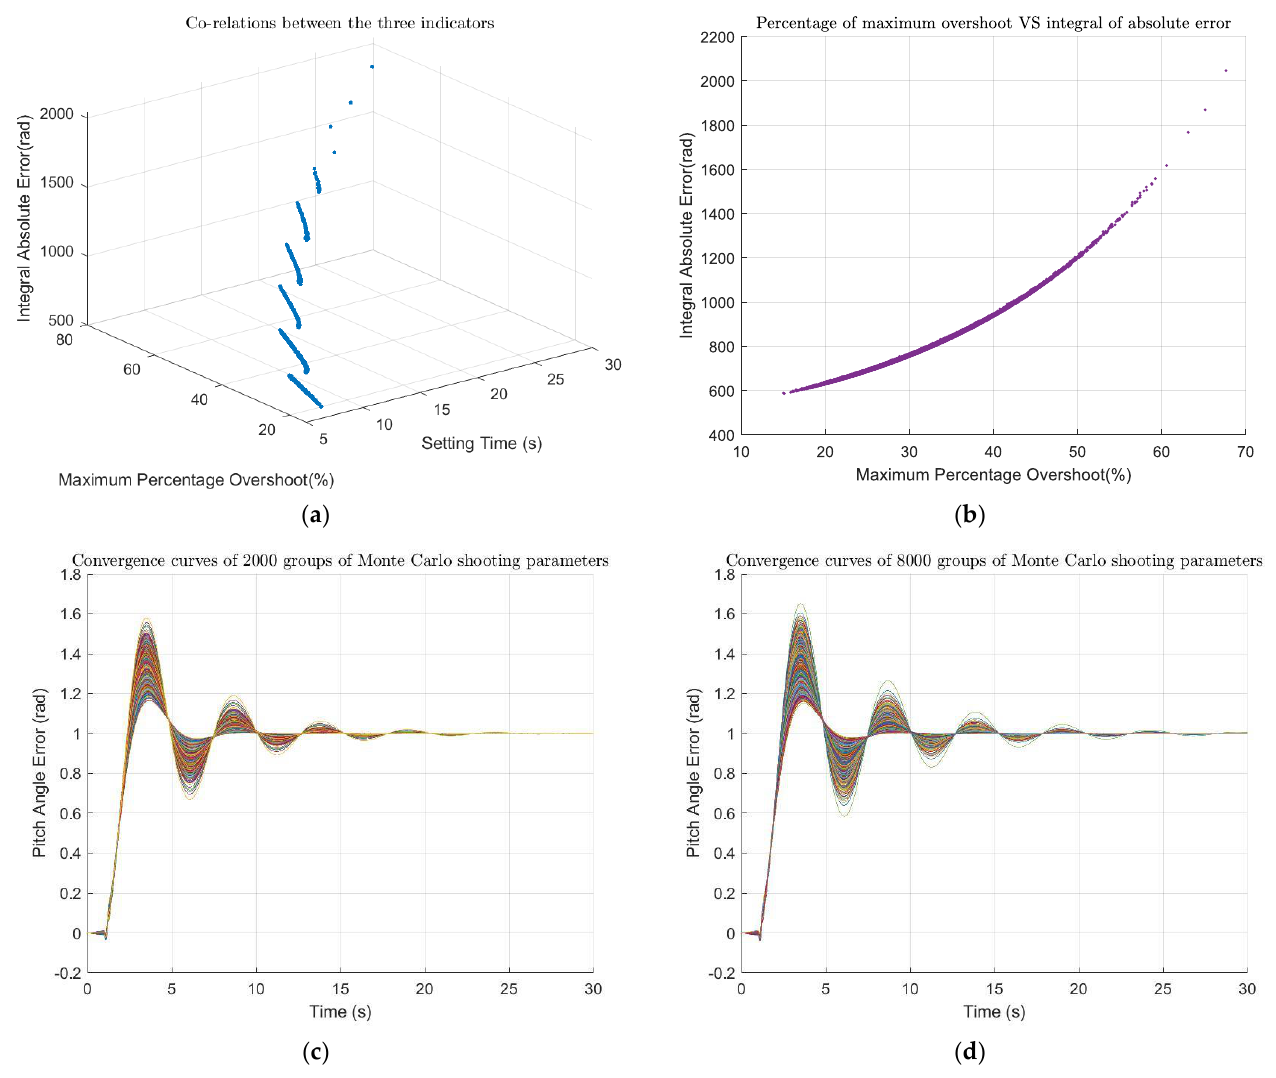
Figure 11. Monte Carlo shooting results. ( a ) The simulation results of the closed-loop system under the combination of the 17,706 valid parameters sets out of total 18,000 (the co-relations between all three indictors); ( b ) The simulation results and the correlation between maximum percentage overshoot and integral absolute error; ( c ) 2000 convergence curves drawn during simulation; ( d ) 8000 convergence curves drawn during simulation.